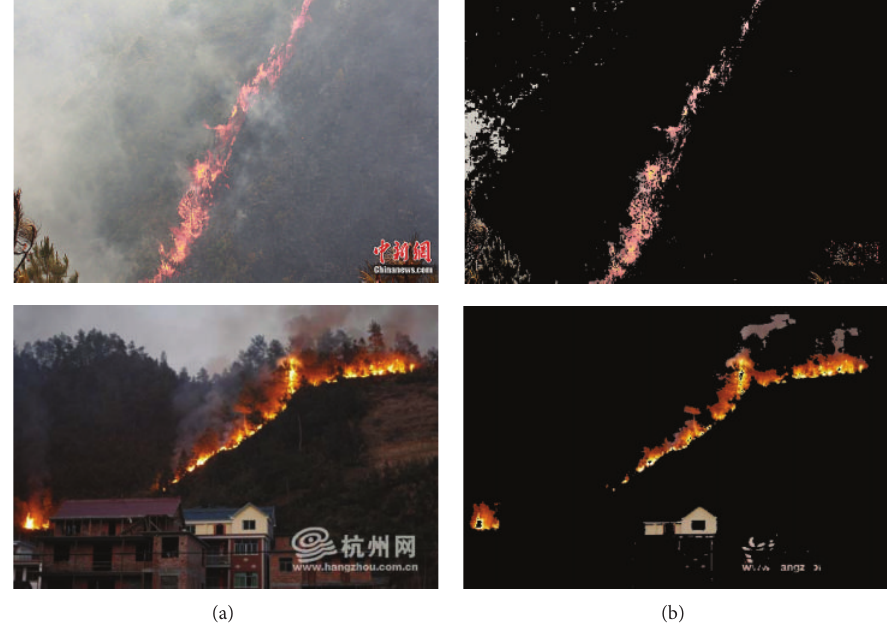
Figure 7: Segmented results from GMM with